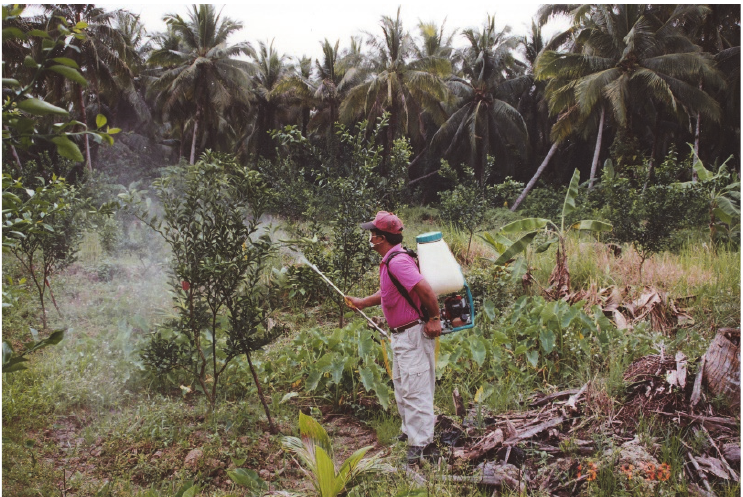
Figure 3. Spraying insecticide with a power knapsack sprayer in an HLB ‐ free citrus orchard.